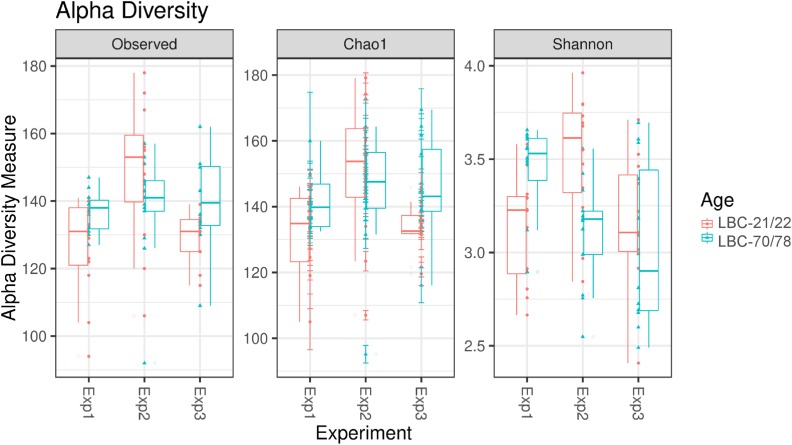
Alpha diversity in samples from caecal content depending on experiment and age at infection. Box-plots showing alpha diversity in samples using the Observed Species index, the Chao1 index and Shannon index (Exp1, Experiment 1; Exp2, Experiment 2; Exp3, Experiment 3; LBC-21/22, Lohmann Brown-Classic, infection at the age of 21/22 days; LBC-70/78, Lohmann Brown-Classic, infection at the age of 70/78 days).